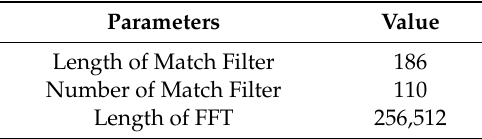
Table 2. PMF-FFT-ZP acquisition